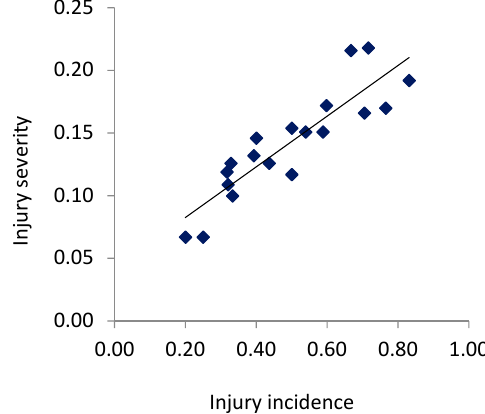
Figure 3. Linear regression ( R 2 = 0.783; slope = 0.2023 ( F (1,17) = 61.29, p < 0.001); intercept is not significantly different from 0) between incidence (proportion of starfish with any evidence of injury) and severity (mean proportion of arms affected among injured starfish) at the scale of reefs.